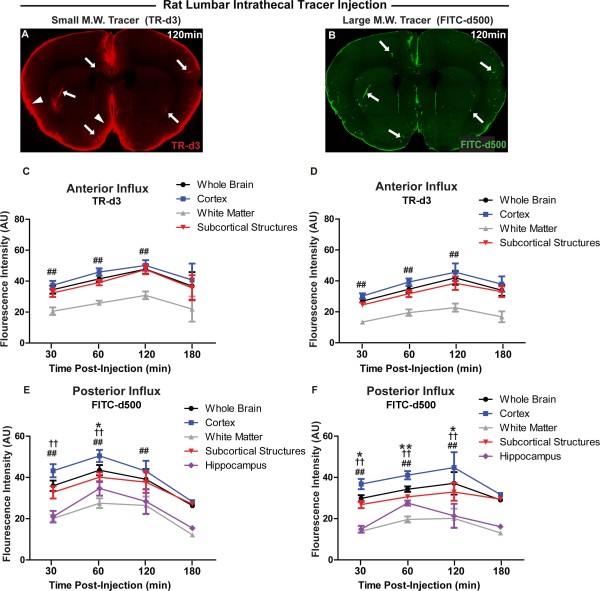
Effect of molecular weight on tracer influx into the brain after lumbar intrathecal infusion. (A-B) Coronal brain slices show penetration of large molecular weight FITC-conjugated dextran (FITC-d500, MW 500kD) and small molecular weight Texas Red-conjugated dextran (TR-d3, MW 3kD) 120 min after lumbar intrathecal co-infusion. FITC-d500 is largely confined to perivascular spaces (B, arrows), while TR-d3 moves readily though the brain parenchyma from perivascular spaces (A, arrows) or from the pial surface (arrowheads). (C-F) Quantification of fluorescent tracer influx into anterior (C-D) and posterior (E-F) brain after lumbar intrathecal infusion, anatomically subdivided into cortex, white matter, subcortical structures, and hippocampus.(*P < 0.05, *P < 0.01 cortex vs. subcortical structures; ##P < 0.01 cortex vs. white matter; †P < 0.05, ††P < 0.01 cortex vs. hippocampus; 2-way ANOVA; n = 3-4 per time point).